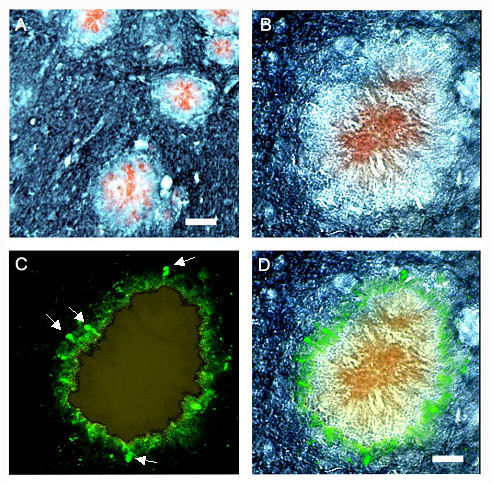
Dual Immunostaining of Na+/K+ ATPase αIII and dystrophic neurites. Horizontal sections were immunostained for Na+/K+ ATPase using DAB with nickel intensification followed by Congo red staining for Aβ plaques. A discernable circumferential void in ATPase staining surrounding the plaque was observed (Panel A, scale bar = 50 μm; Panel B, scale bar = 16.67 μm). Immunofluorescent staining of dystrophic neurites using the anti-phosphorylated neurofilament antibody SMI-312 followed by Congo red staining demonstrate a close relationship between amyloid plaques and dystrophic neurites (Panel C; white arrows demarcate the neurites). Congo red yellow fluorescence was digitally suppressed to more clearly reveal the green-stained neurites (scale bar = 16.67 μm). Panel D is a digital overlay of the fluorescein-labeled dystrophic neurite image onto the bright field peroxidase-labeled Na+/K+ ATPase + Congo red image which demonstrates that dystrophic neurites are present predominantly in the zone devoid of Na+/K+ ATPase staining surrounding the congophilic plaques (scale bar = 16.67 μm).